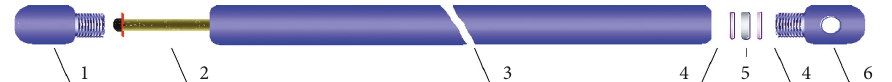
Figure 6: Sketch map of composition structure of CO sheet; (6) spillage head.